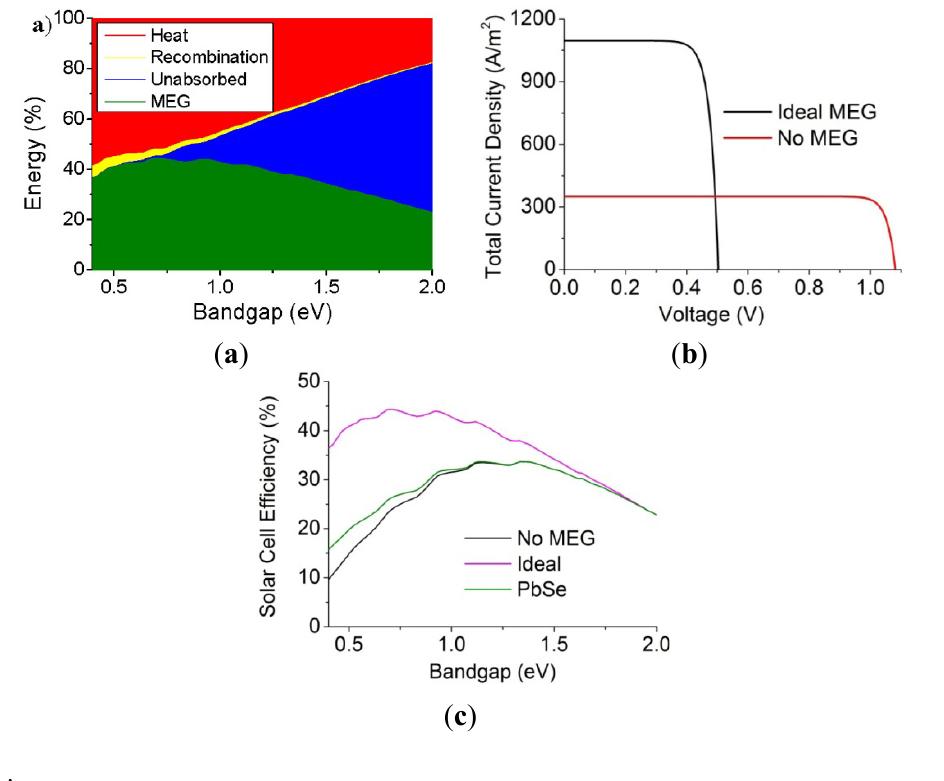
Figure 6. ( a ) Energy division in a QD sample exhibiting ideal MEG modeled using Equation (12) if illuminated by the AM1.5 solar spectrum. As the bandgap increases a larger fraction of solar photons do not have enough energy to be absorbed, indicated by the blue section, and for lower bandgap the threshold for MEG is lower; ( b ) Comparison of current density as a function of operating voltage for QD solar cells of optimum E and without ideal MEG; ( c ) Comparison of solar cell efficiency vs. E Equation (13), for PbSe QD with experimentally derived η and hv ( a ) and the case with no